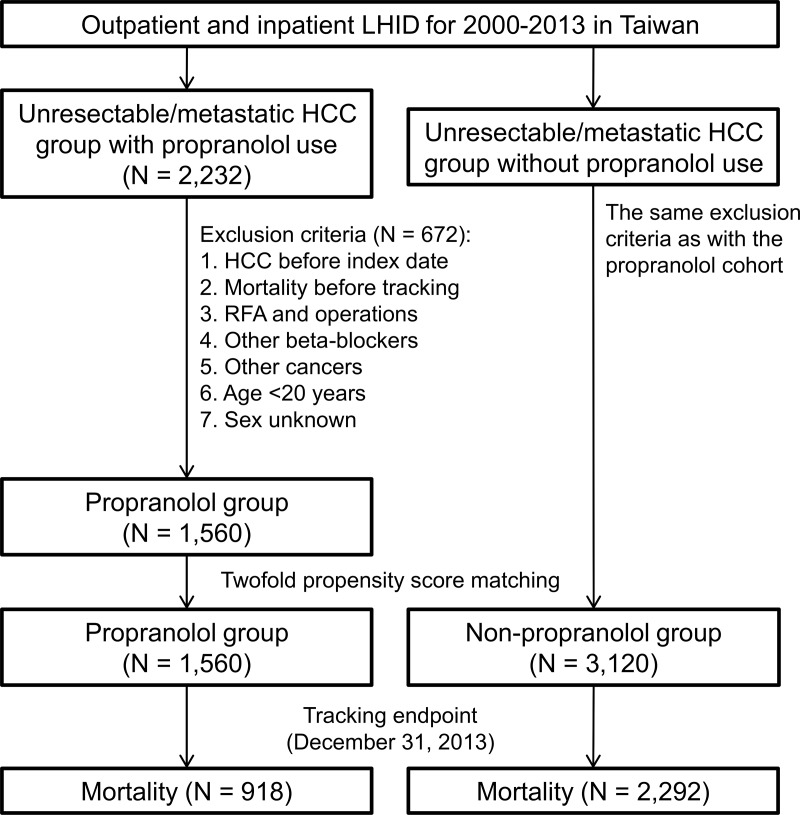
Flowchart for matching patients with unresectable/metastatic HCC according to propranolol exposure.LHID, Longitudinal Health Insurance Database; HCC, hepatocellular carcinoma; RFA, radiofrequency ablation. Operations include lobectomy, segmentectomy, hepatectomy, and liver transplantation.